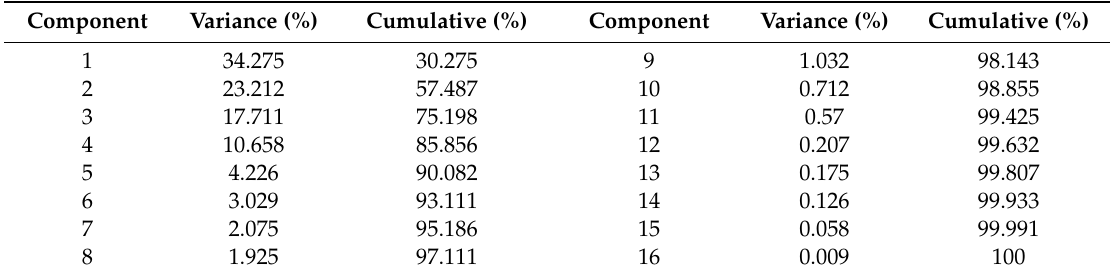
Table 3. Variance and cumulative accuracy of each